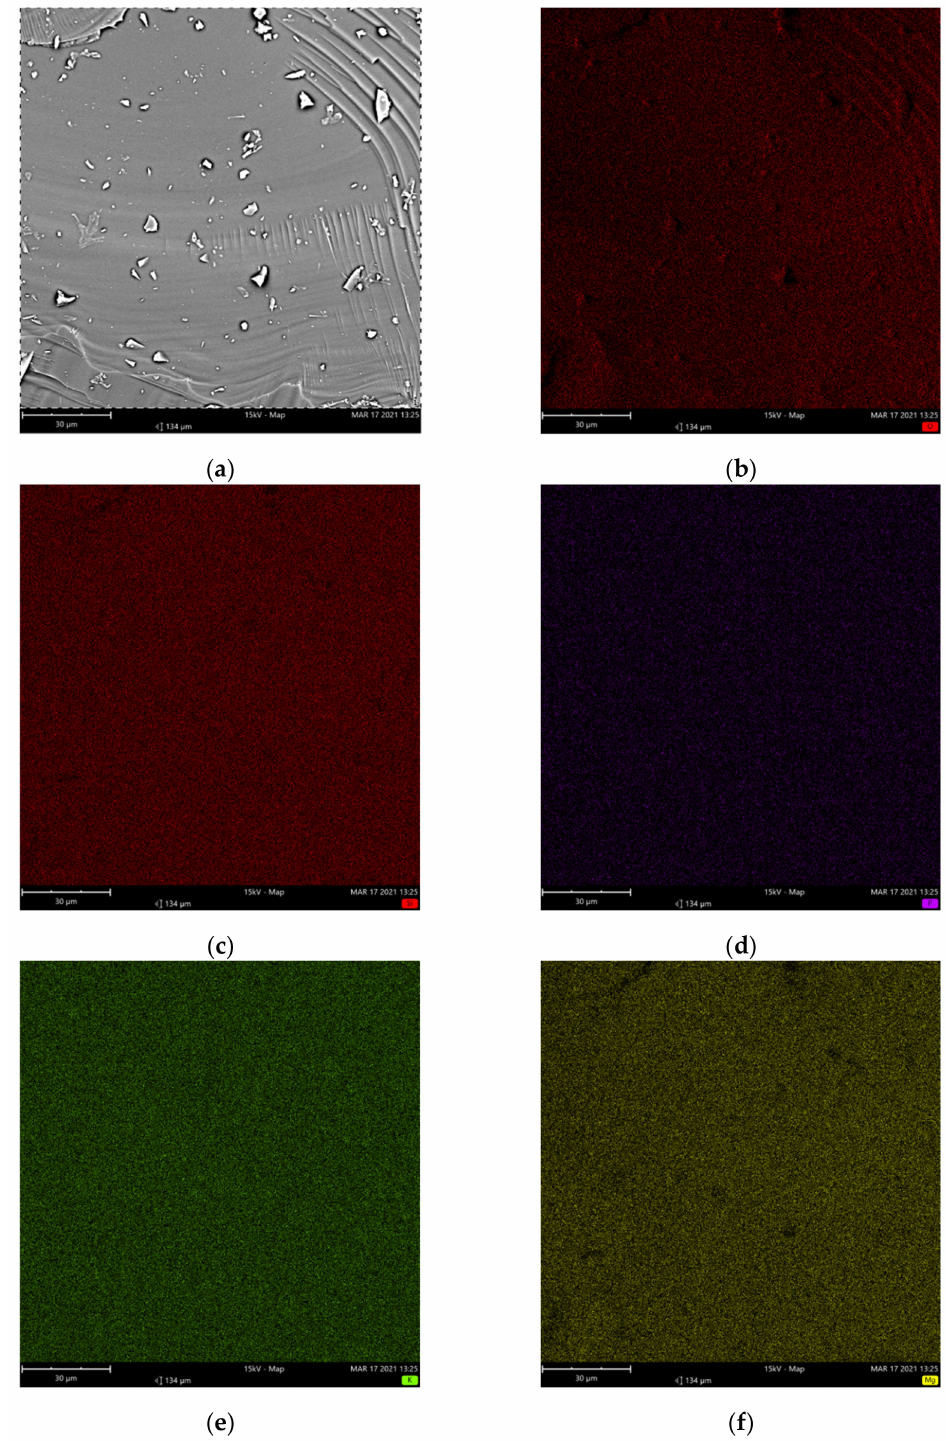
Figure 2. SEM image of the 45Si2P glass sample (backscattered electrons: BSEs) ( a ) and associated EDS elemental maps for ( b ) O, ( c ) Si, ( d ) P, ( e ) K, and ( f )